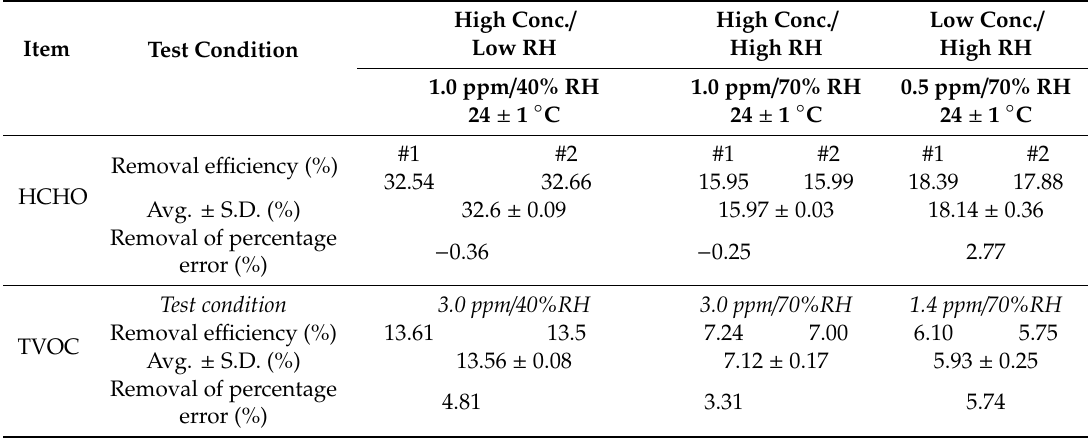
Table 3. Removal e ffi ciency of duplicate analysis for chemical air